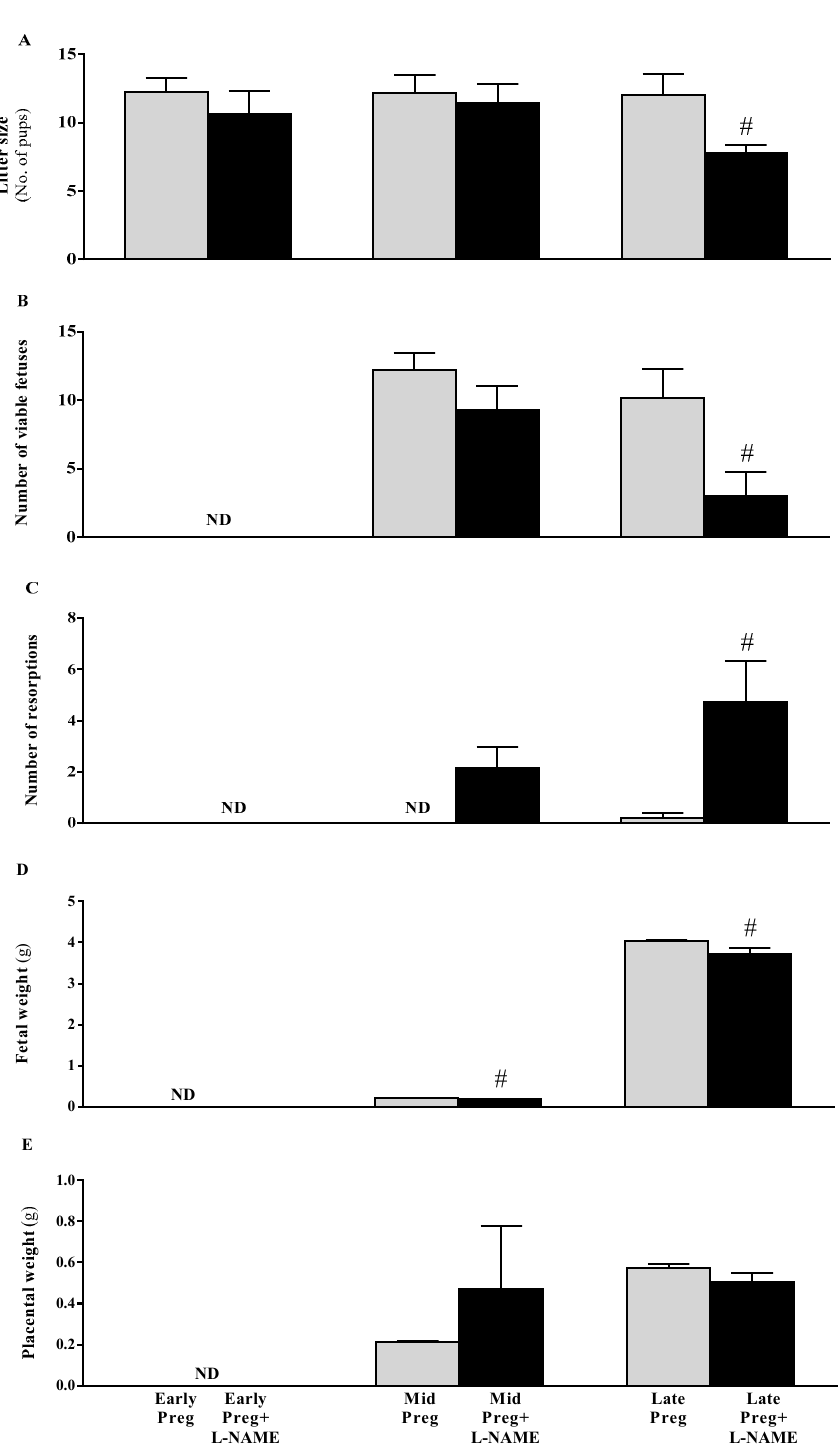
Figure 2. Fetal and placental parameters: ( A ) Litter size, ( B ) Number of viable fetuses, ( C ) Number of reabsorptions, ( D ) Fetal weight and ( E ) Placental weight in Early, middle (Mid) and Late-pregnant rats treated with saline or L-NAME. Values are represented as mean ± SEM. # P < 0.05 versus respective saline-treated pregnant groups.